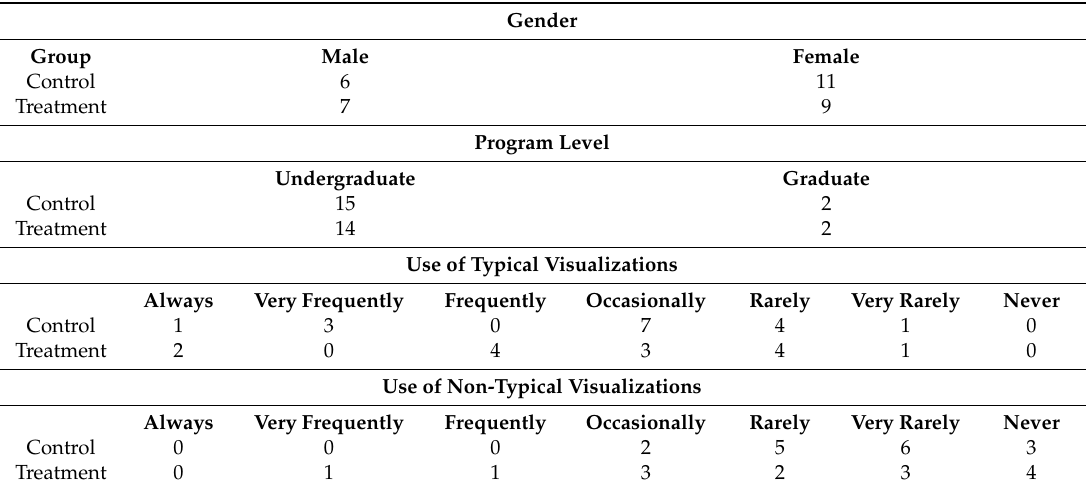
Table 1. Summary of participant demographics for visualization literacy study 1 .